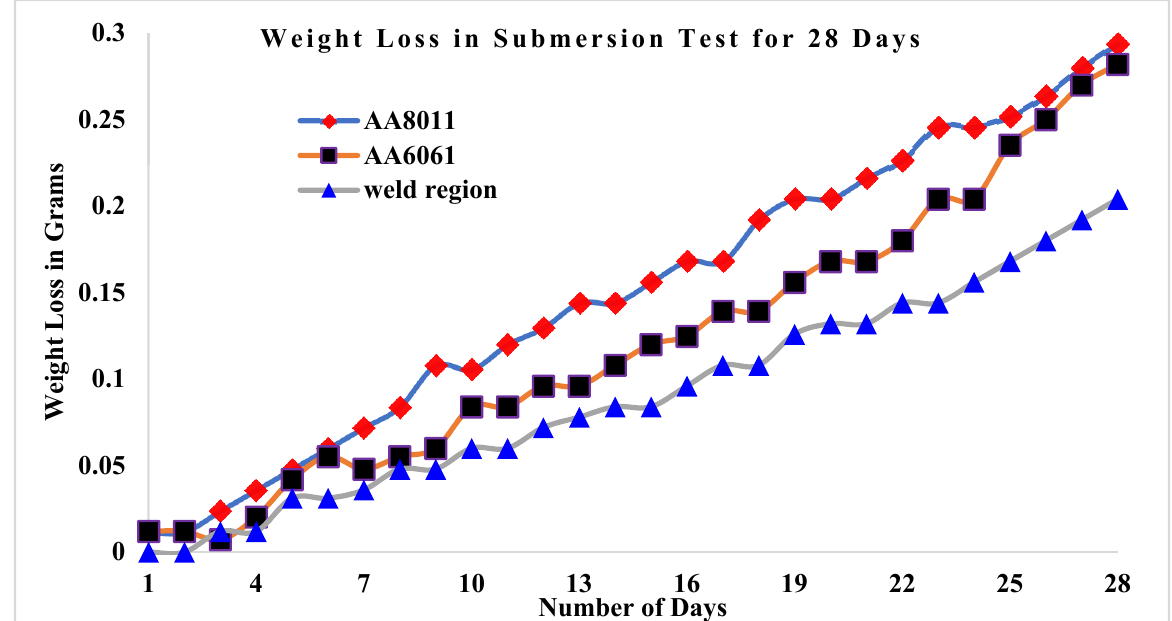
Figure 9. Weight loss rates for base materials and weld region sample against the number of days submerged in seawater.